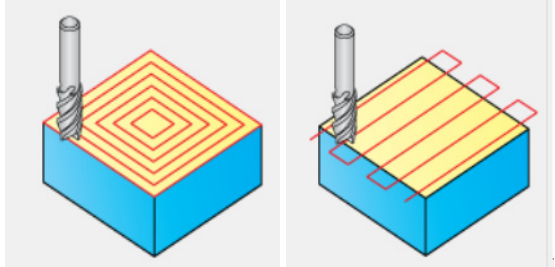
Figure 4. Roughing strategies: Contour (left) and Hatch (right) [12]